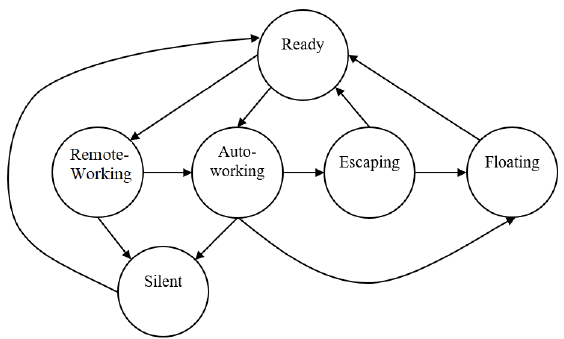
Figure 6 . State transition diagram of FSM adopted by onboard software. Figure 6. State transition diagram of FSM adopted by onboard software.